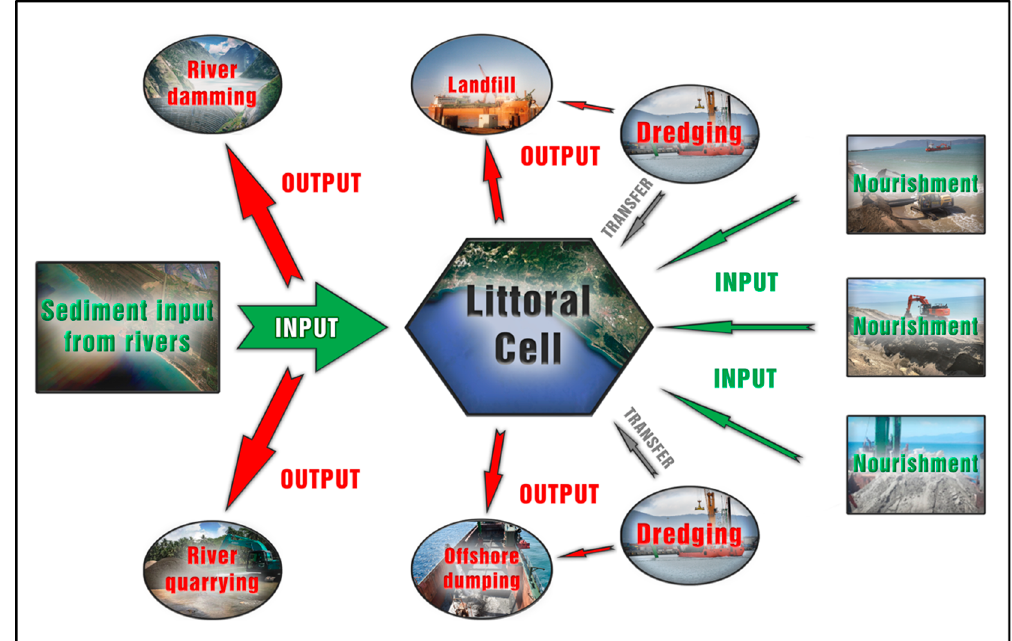
Figure 3. Flux diagram showing the general concepts related to the anthropogenic sediment budget calculation. The river bedload decrease is the main driver of the erosion effects, and it is not matched by all the other activities involving sediment input, output and transfer. Green and red arrows represent inputs and outputs respectively; gray arrows represent transfers.